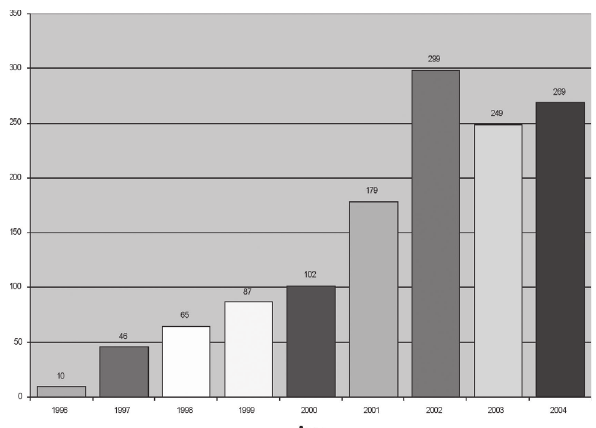
Fig. 4 - Distribuição anual de enxertos entre setembro de 1996 e dezembro de 2004